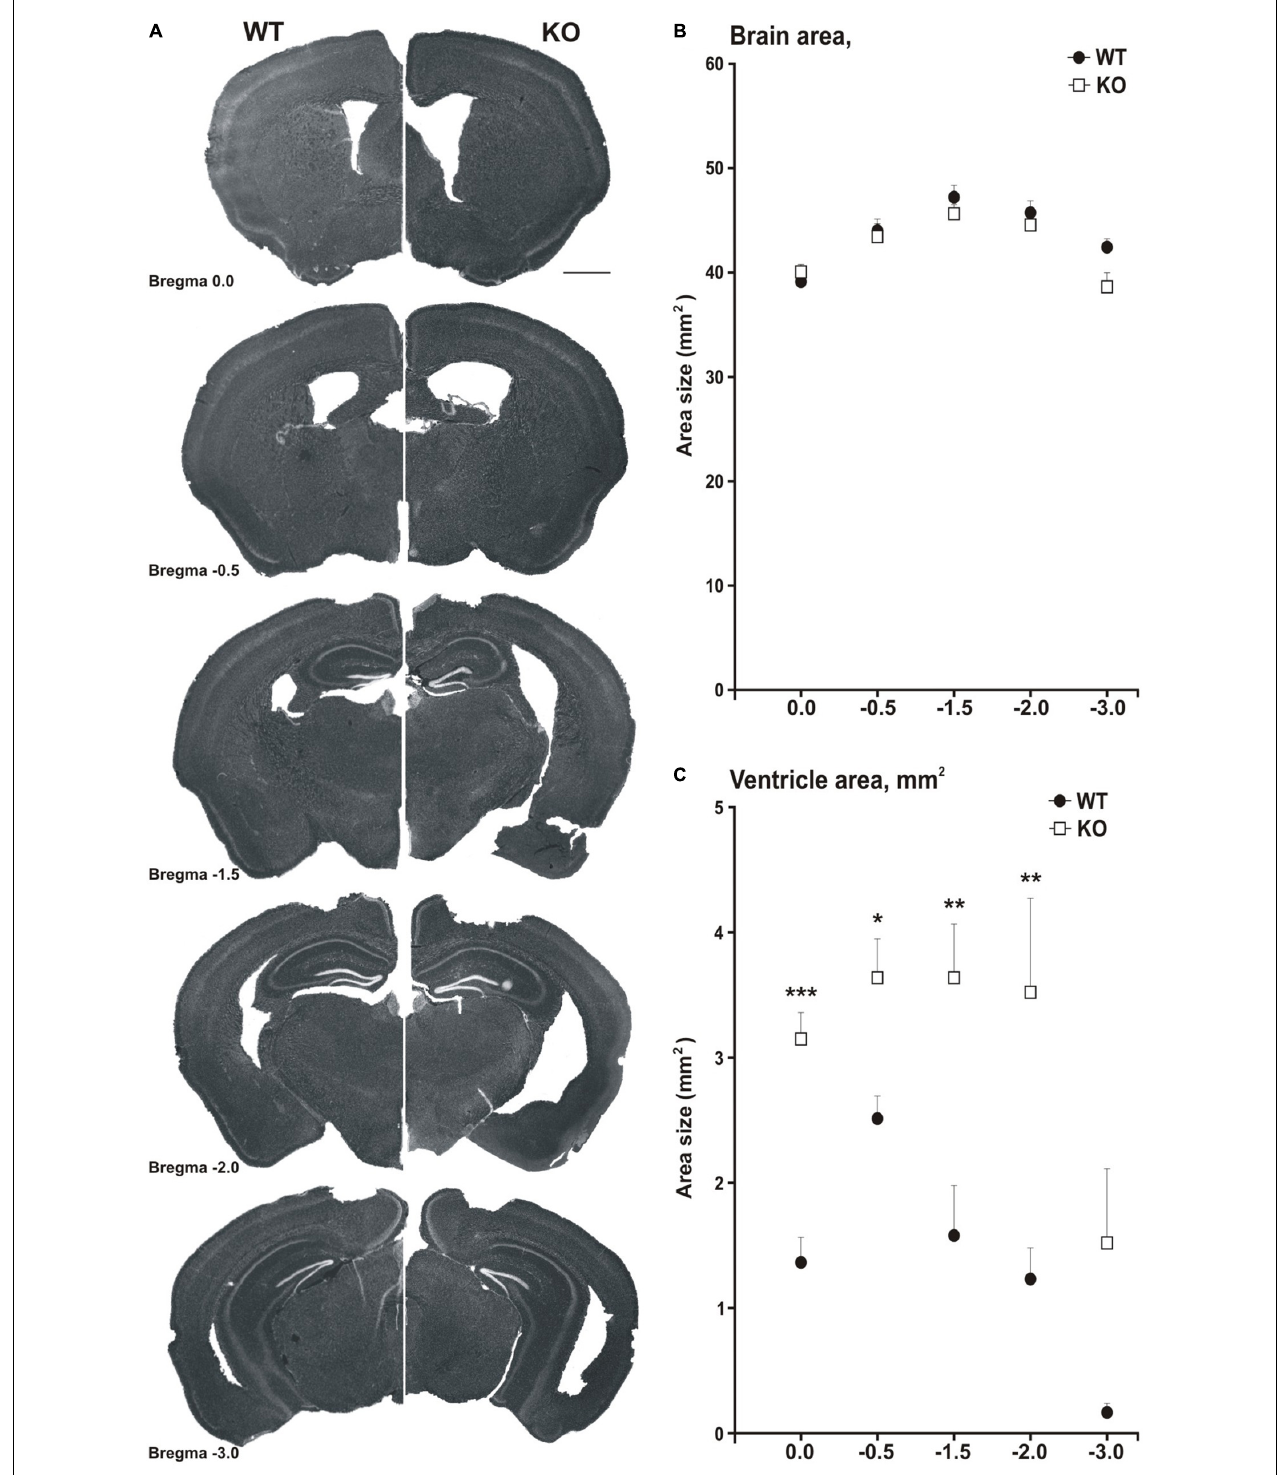
FIGURE 5 | MIM KO mice show ventricle enlargement. (A) Coronal brain slices of WT mice (on the left side) and MIM KO mice (on the right side) at different distances from Bregma (0.0, –0.5, –1.5, –2.0, and –3.0). (B) Total brain area was similar for MIM KO and WT mice. (C) The area of ventricles averaged for each slice set at different distances from Bregma was significantly bigger for MIM KO mice than for WT mice. ∗ denotes statistical significance: ∗ p < 0.05, ∗∗ p < 0.01, ∗∗∗ p < 0.001. Scale bar 1000 µ m.